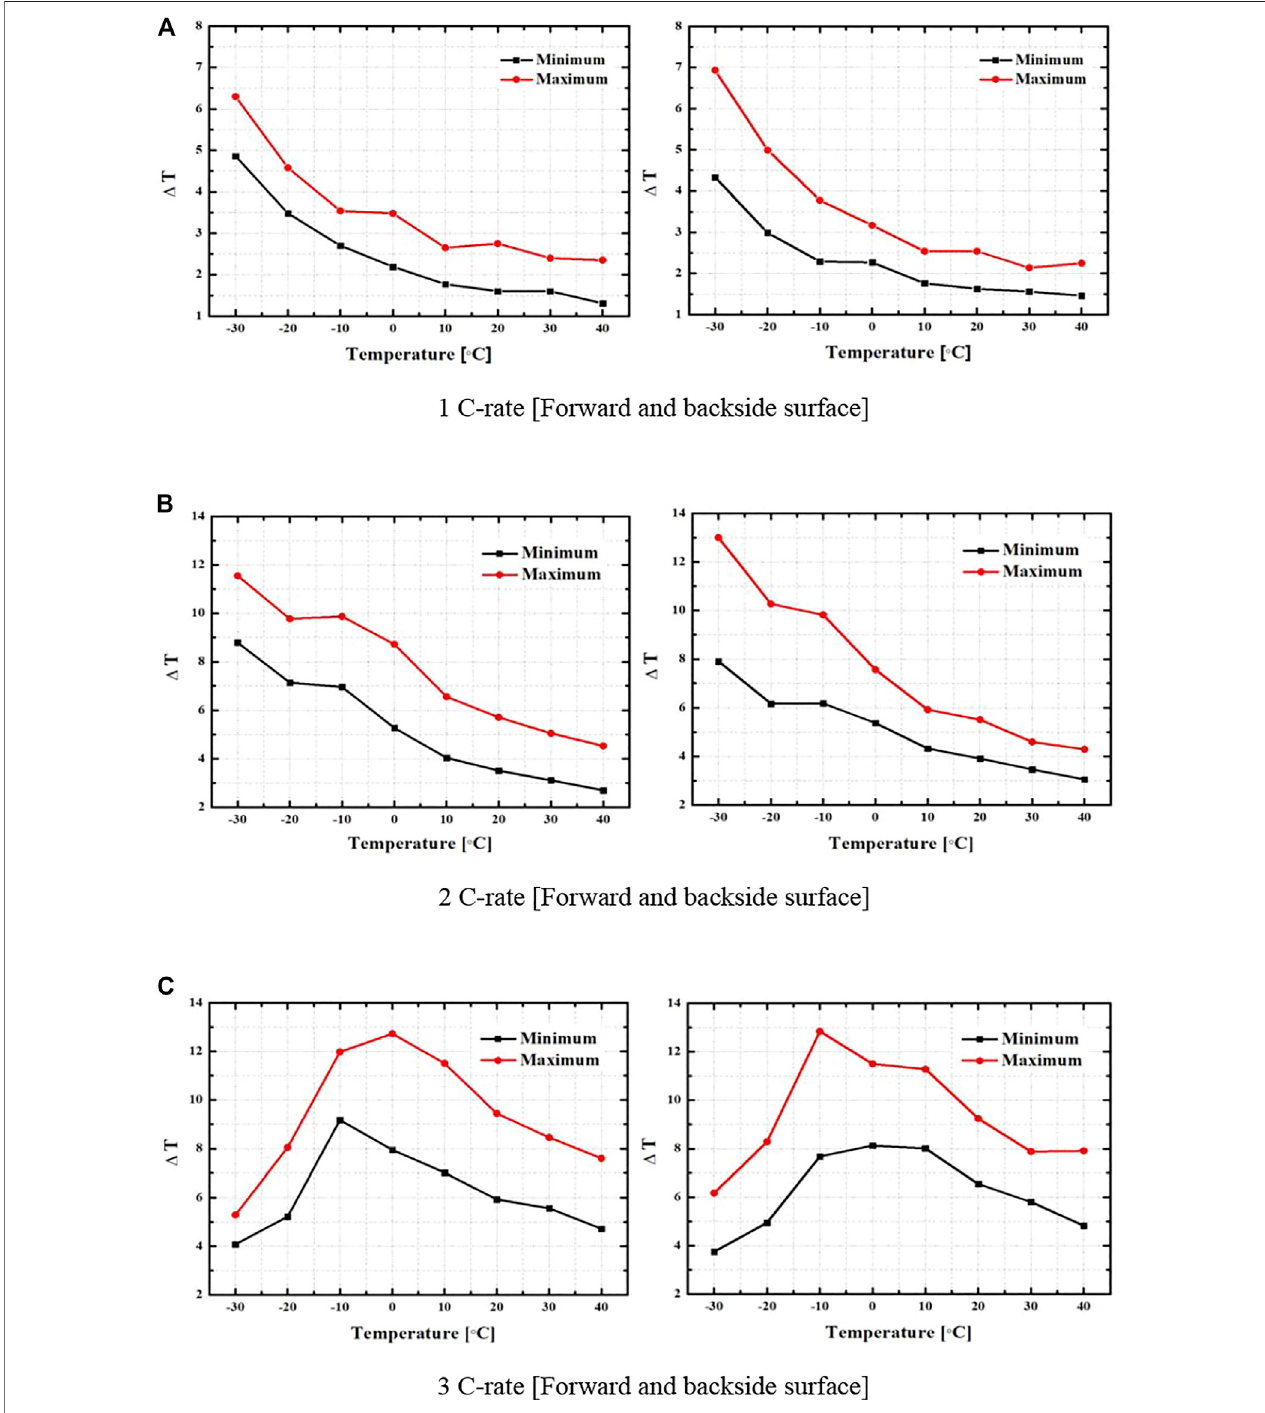
FIGURE 8 | Temperature variation of critical and uncritical location. (A) 1 C-rate (Forward and backside surface). (B) 2 C-rate (Forward and backside surface). (C) 3 C-rate (Forward and backside surface).